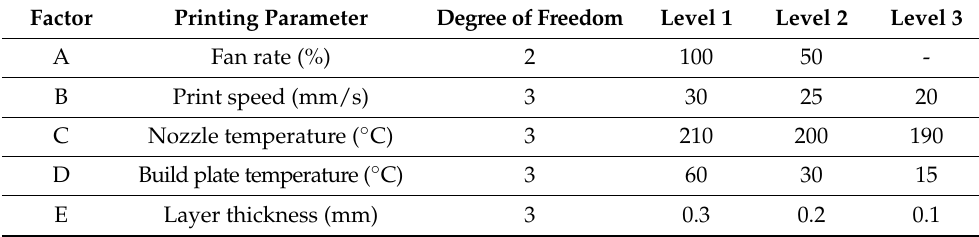
Table 2. Level of each factor.